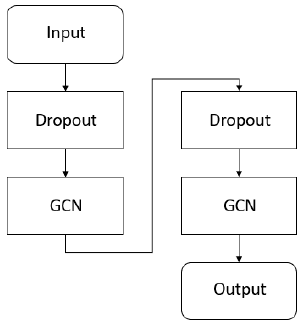
Figure 4. GCN model.